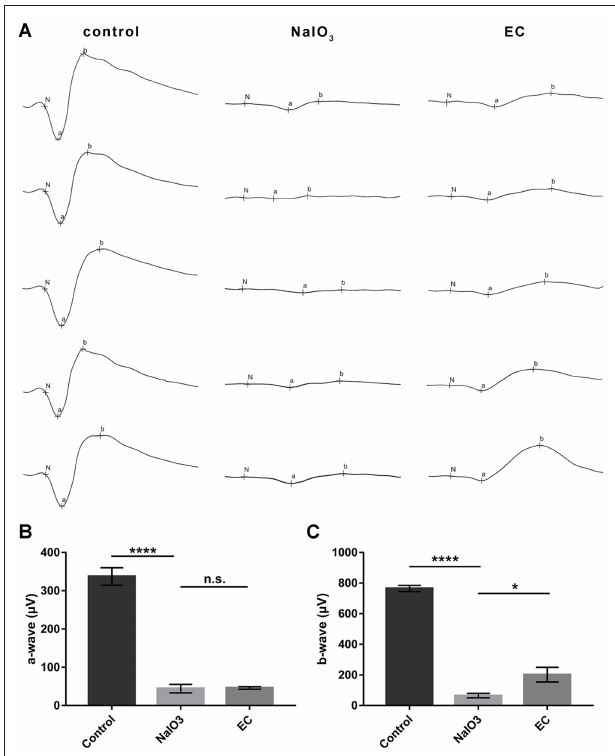
FIGURE 4 | EC partially rescued retinal function impaired by NaIO 3 administration. (A) Dark-adapted 3.0 ERGs of full-field ERG in the control, NaIO 3 , and EC groups. (B) A steep decline of a-waves was seen after NaIO 3 injection, EC intervention did not exhibit significant benefits on a-wave amplitude. (C) EC exerted marked recovery effects on b-wave amplitude. Values are presented as mean with SEM, n = 5 or 6; n.s., no significance, * p < 0.05, **** p <